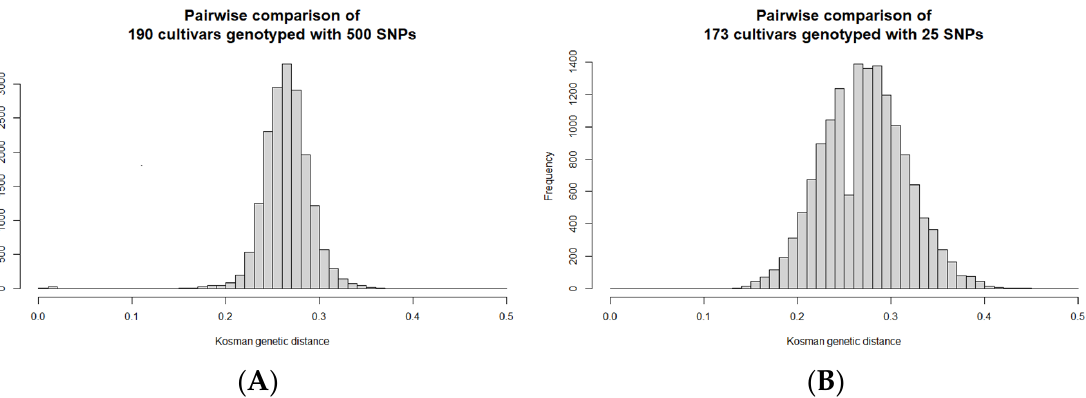
Figure 3. Histogram (frequency distribution) of pairs of potato cultivars (Y) vs. Kosman’s genetic distances (X). ( A ) 190 cultivars genotyped with SeqSNP at 500 SNP positions. Average distance = 0.265 ± 0.025. ( B ) 173 unique potato cultivars genotyped with SeqSNP at a selected panel of 25 SNPs. Average distance = 0.274 ± 0.044.